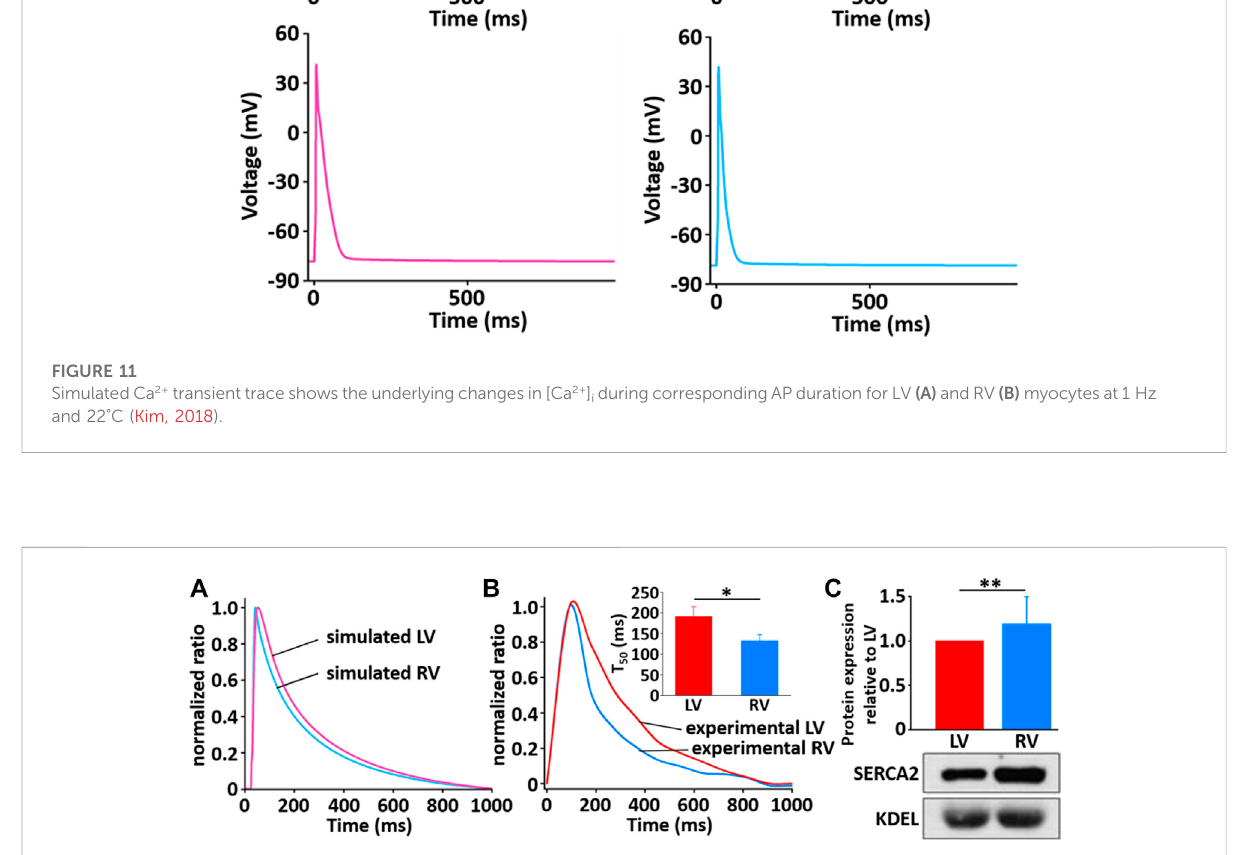
FIGURE 12 Comparison of normalized Ca 2+ transients in model (A) and experimental recordings (B) for LV and RV myocytes at 1 Hz and 22 ° C (Kim, 2018). The peak ratio of the Ca 2+ transients in the LV and RV myocytes was not different; however, the decay of the Ca 2+ transients was much slower in LV thaninRV myocyte: insertshowsthatT 50 ofLVcells(190.1 ms± 24.8 ms, n =6)issigni fi cantly differentfromthatofRVcells(132.8ms±15.2 ms, n = 6). (C) Veri fi cation of protein expression of SERCA2a proteins between LV and RV by immunoblotting. Representative blots and